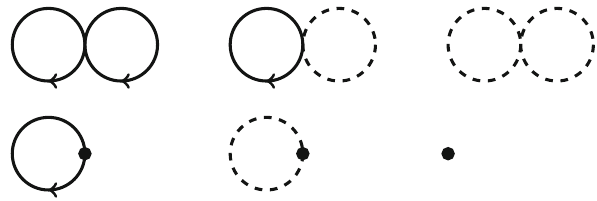
Fig. 2 NNLO diagrams for the pressure in the symmetric phase. A solidlinecorresponds tothechargedpionandadashedlinecorresponds to the neutral pion. A black dot is a mass insertion or a temperature- independent